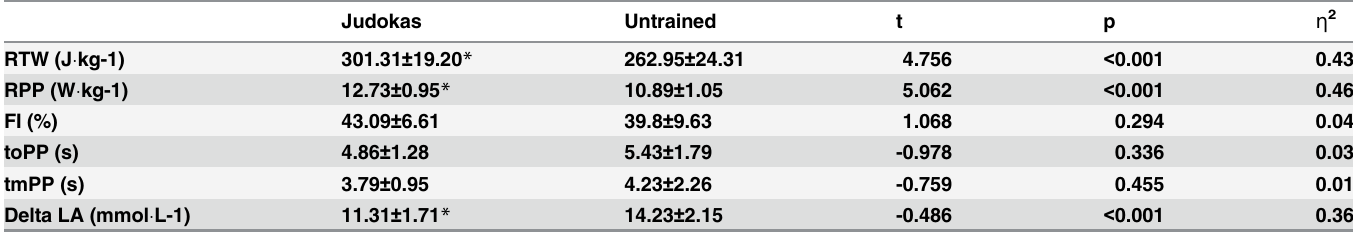
Table 4. Results of the Wingate test for judokas and untrained university students obtained during the experiment (mean ± SD, t, p, Ƞ 2 ). Judokas Untrained t p ƞ 2 RTW (J (cid:1) kg-1)